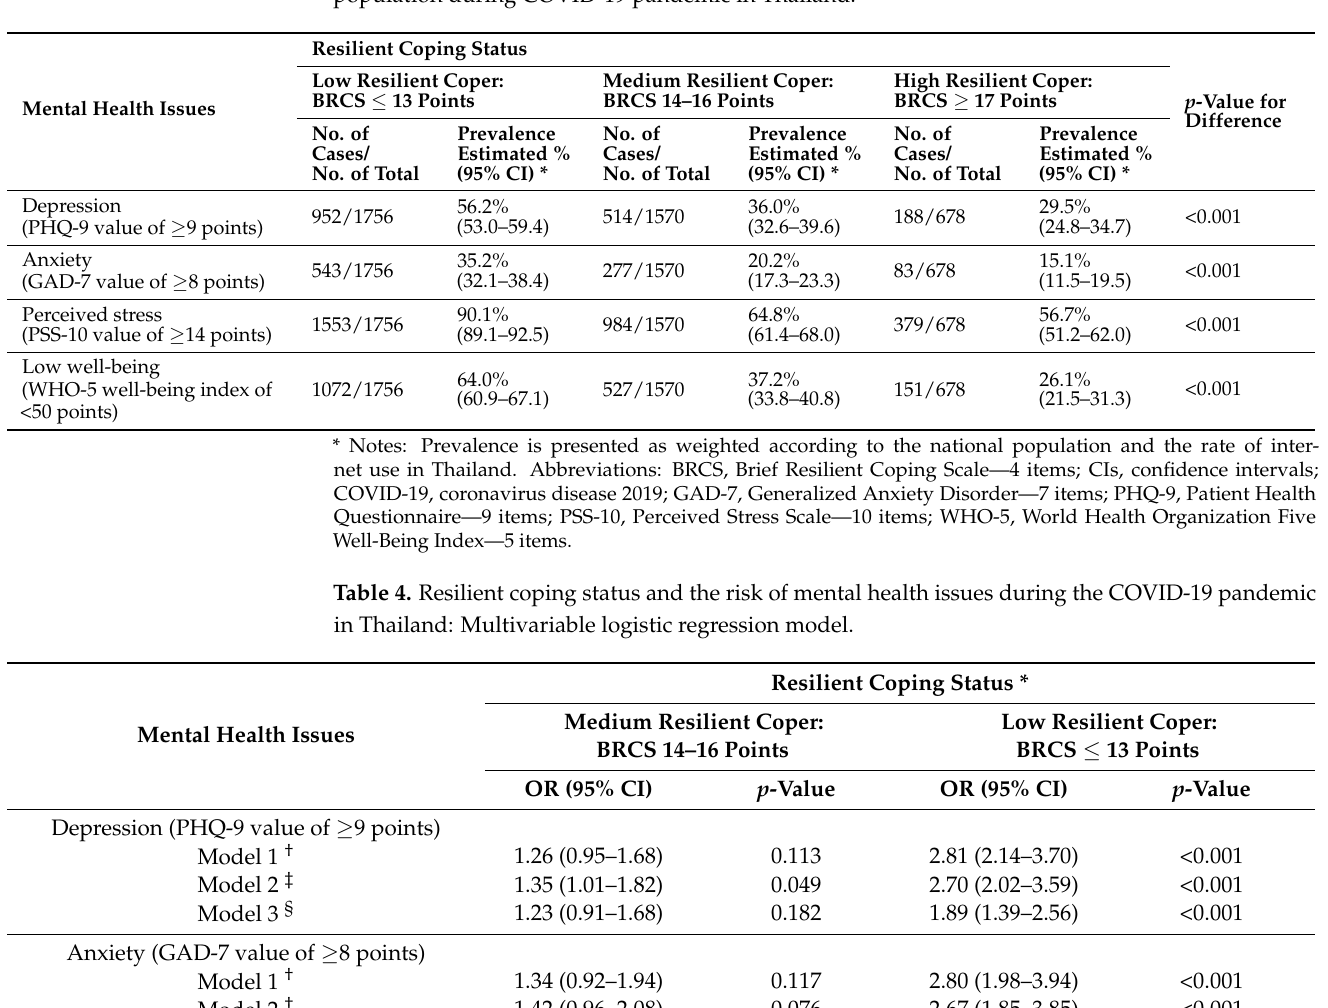
Table 3. Prevalence of mental health issues according to resilient coping status among general population during COVID-19 pandemic in Thailand.